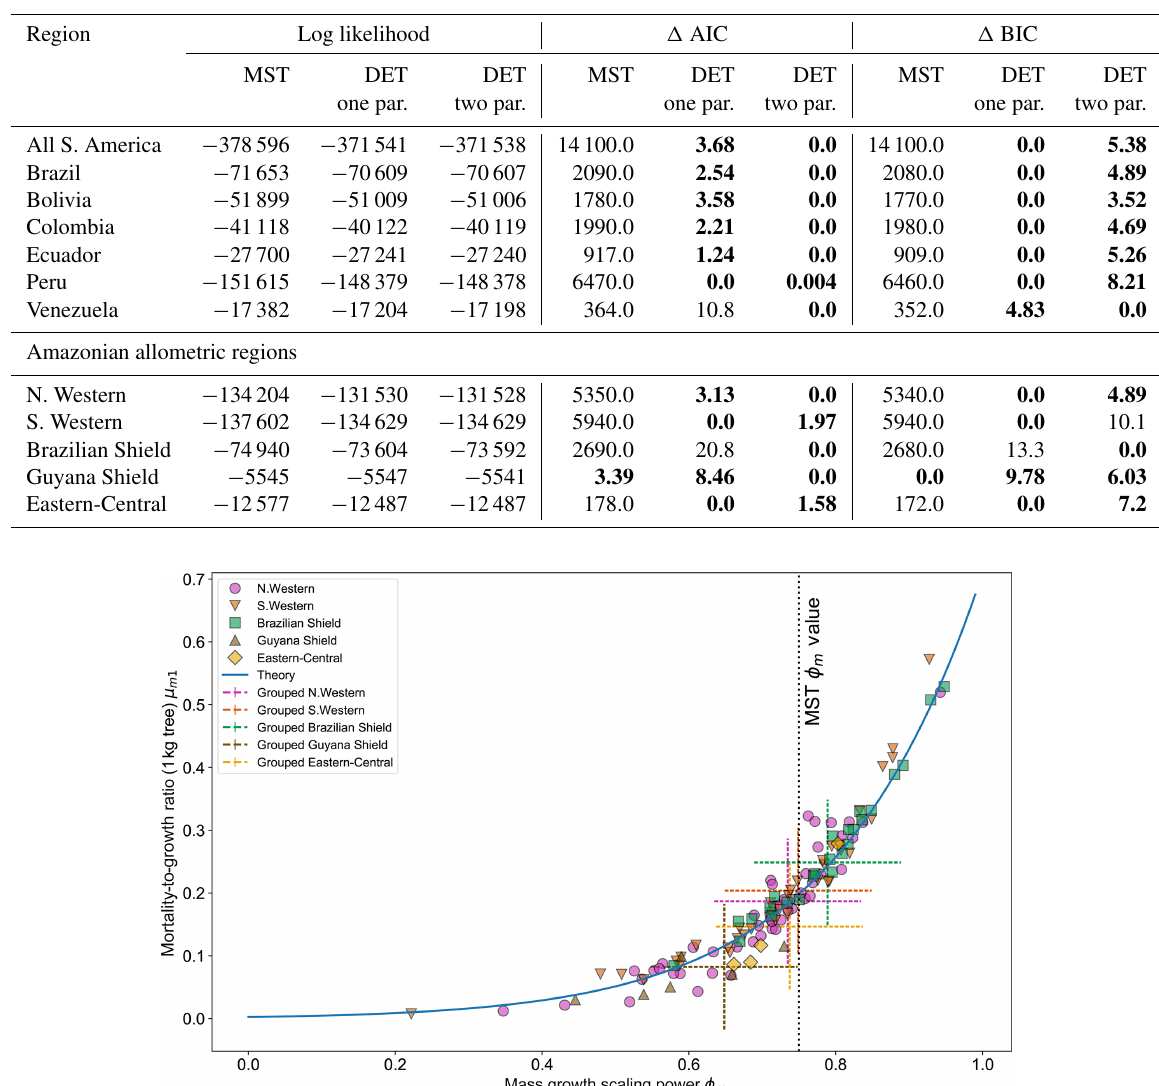
Table 5. Model comparison for fits to mass size distributions. This table shows the log likelihood of each model’s fit and the corresponding AIC and BIC model comparison criterion. The best model has the lowest AIC or BIC; here the difference is shown compared to the best model, meaning the best model has a score of 0. Models other than the best are strongly rejected if they have a value greater than 10. The best model and those not rejected are shown in bold.